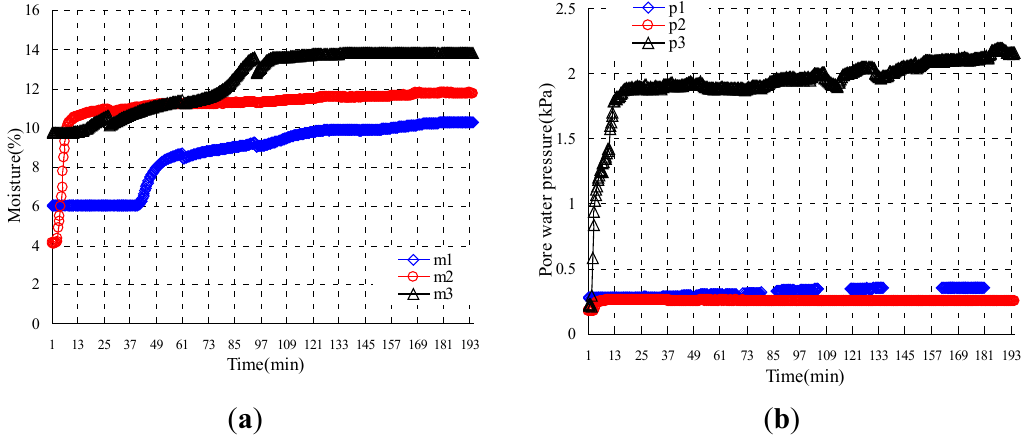
Figure 11. Soil Sample 3-45 mm/h: ( a ) Moisture content of m1, m2, and m3; and ( b ) pore water pressure of p1, p2, and